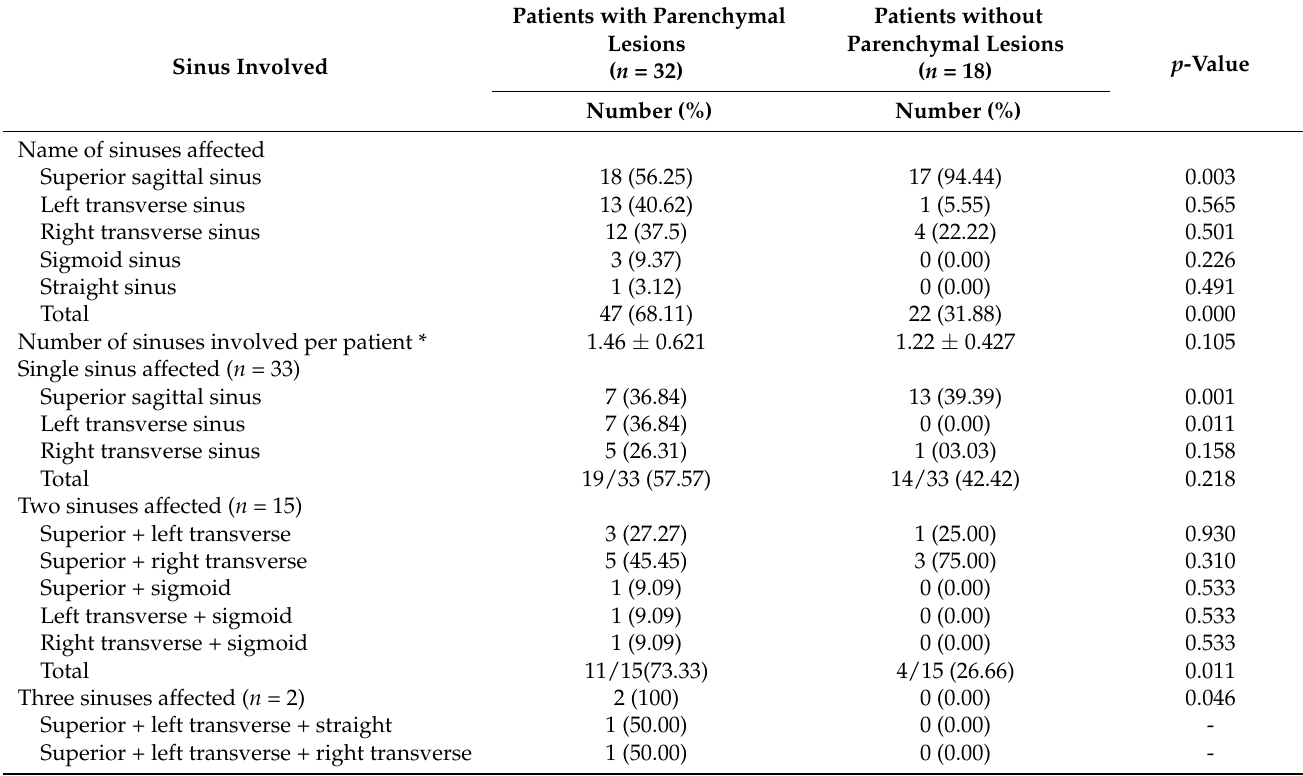
Table 3. Comparison of neuroradiological findings in patients with or without parenchymal lesions on CT scan ( n = 50). Patients with Parenchymal Lesions Sinus Involved